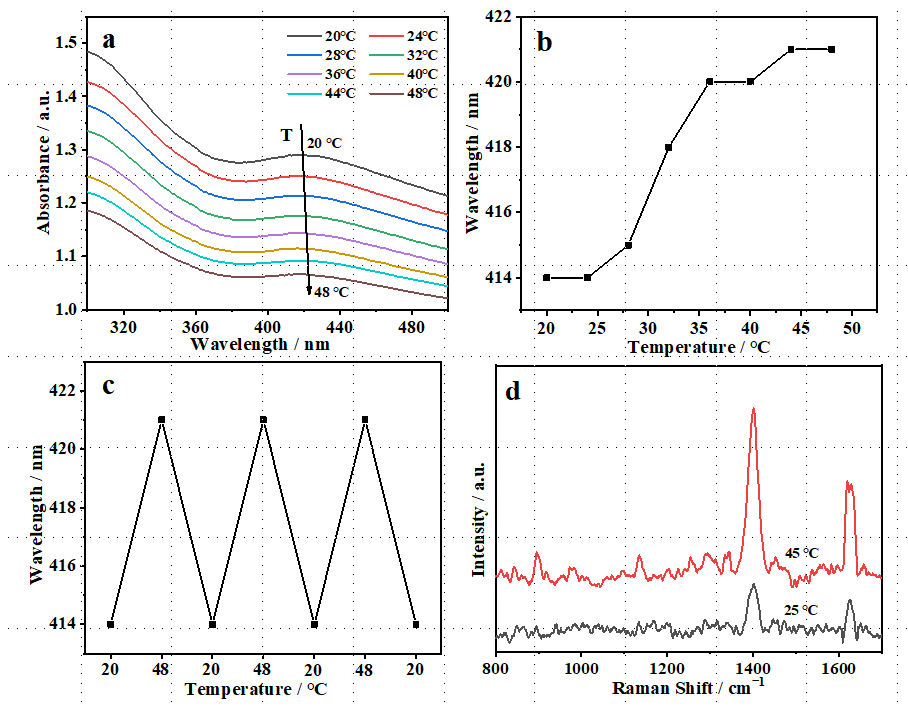
Figure 4. UV-Vis absorption spectra of TM@TiO 2 @Ag with temperature change ( a ); the relationship between LSPR peak wavelength of TM@TiO 2 @Ag and temperature ( b ); the relationship between LSPR peak position of TM@TiO 2 @Ag and temperature cycle ( c ); SERS spectra of 10 − 7 M OFL at dif- ferent temperatures ( d ).